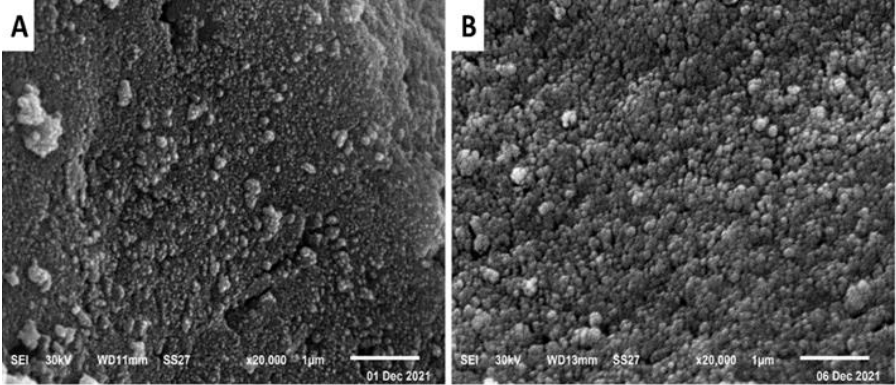
Figure 6. SEM of silver nanoparticles biosynthesized using ( A ): A. glabra and ( B ): A. squamosa , pho- tographs at ×20,000.